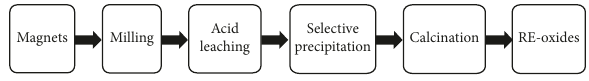
Figure 1: Recovery of rare earths from scrap of permanent